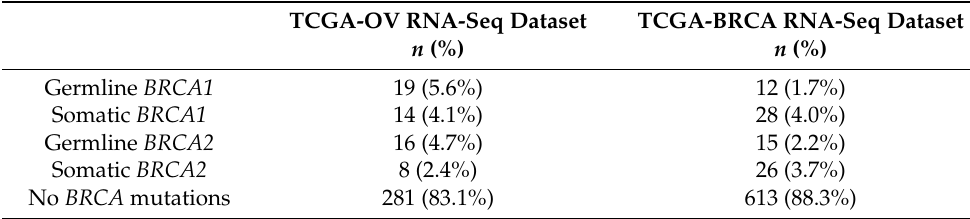
Table 1. Sample groups in the breast (TCGA-BRCA) and ovarian (TCGA-OV) cancer datasets were used as separate layers in self-organizing maps (SOM)